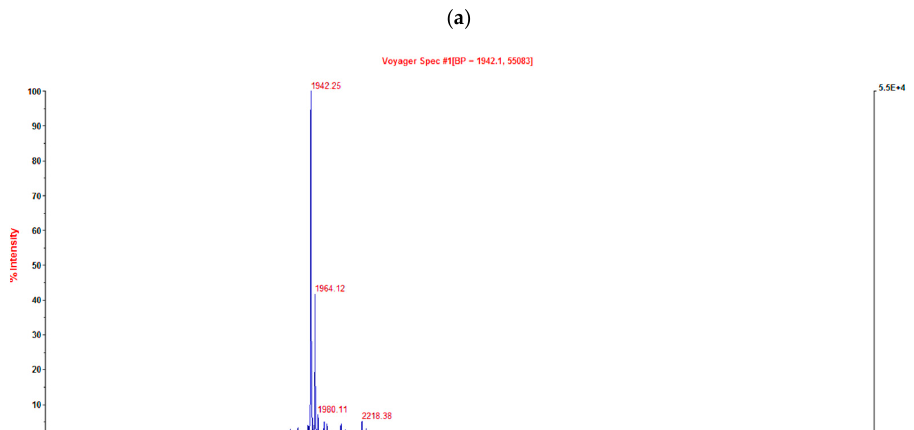
Figure 6. The ( a ) RP-HPLC chromatogram and ( b ) MALDI-TOF mass spectrum of the purified synthetic phylloseptin-PHa.